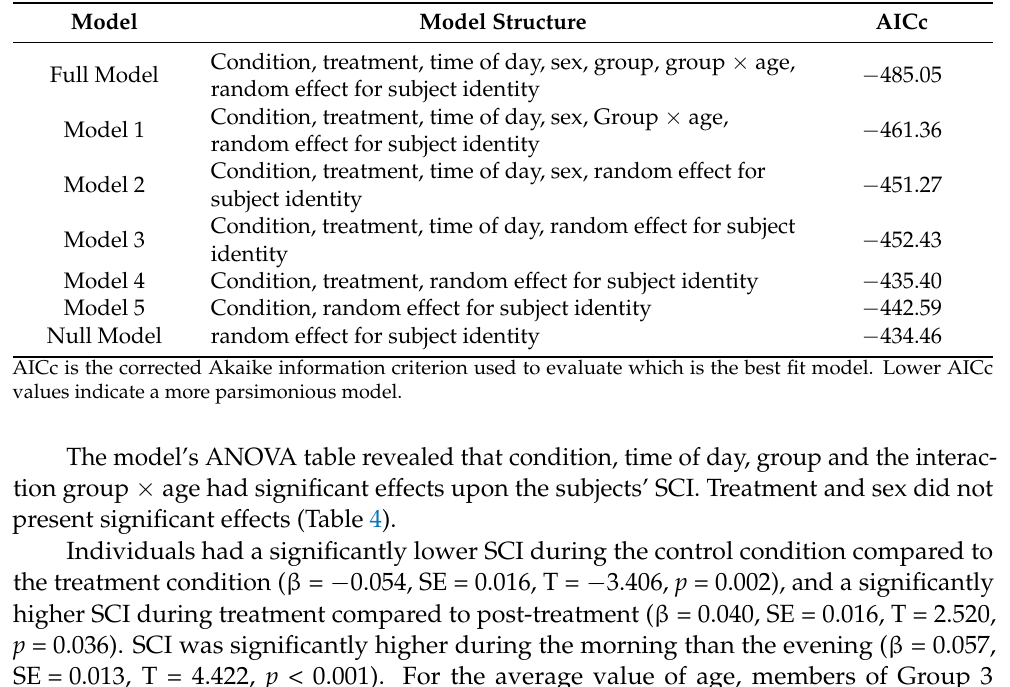
Table 8. Model structures and AIC values obtained during model selection for social competence.